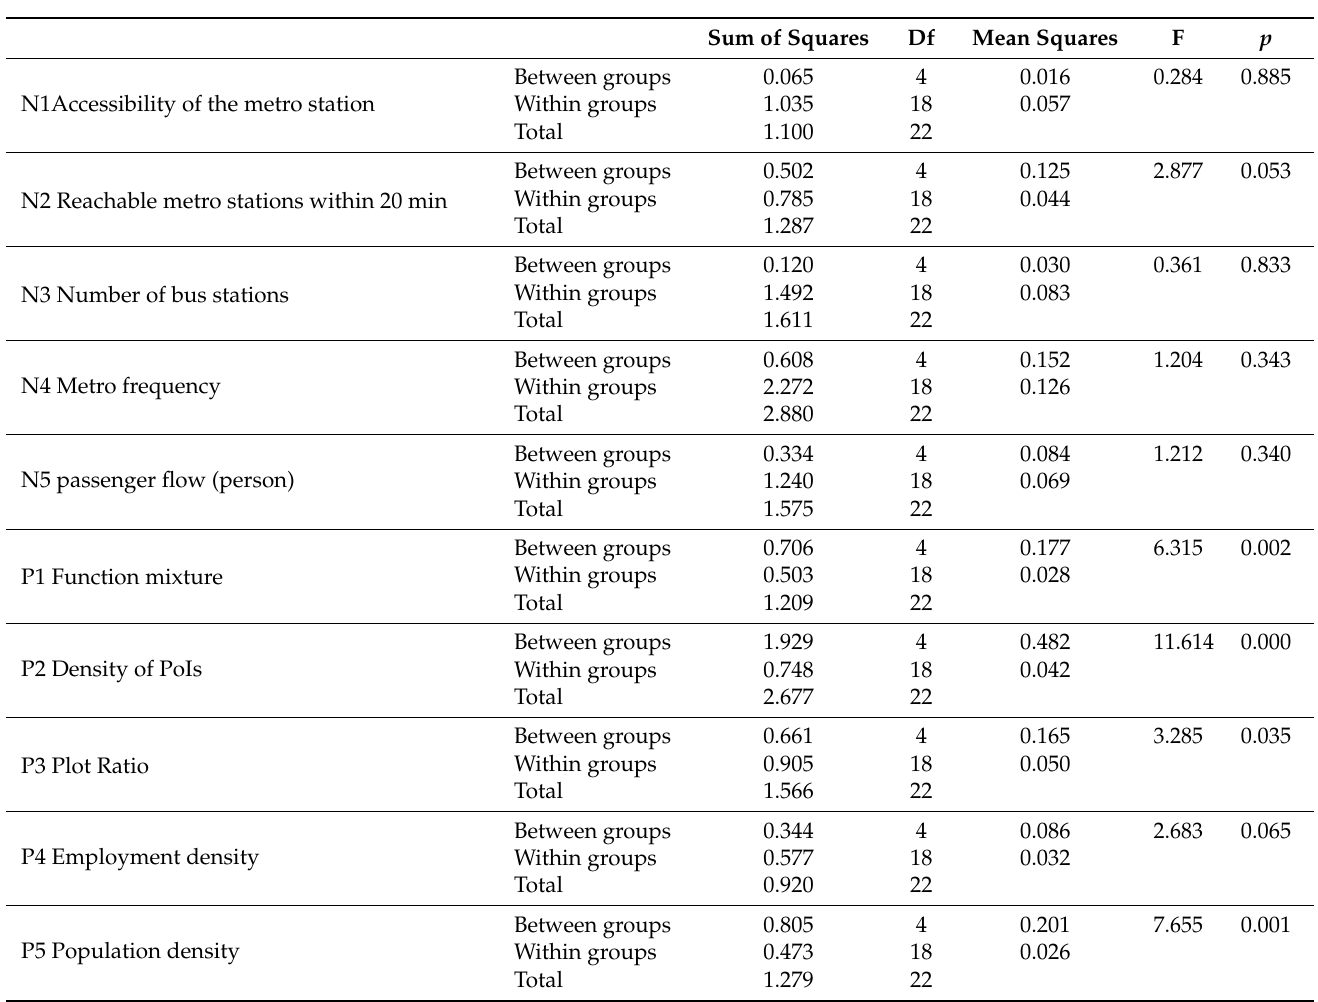
Table A2. One-way ANOVA result.